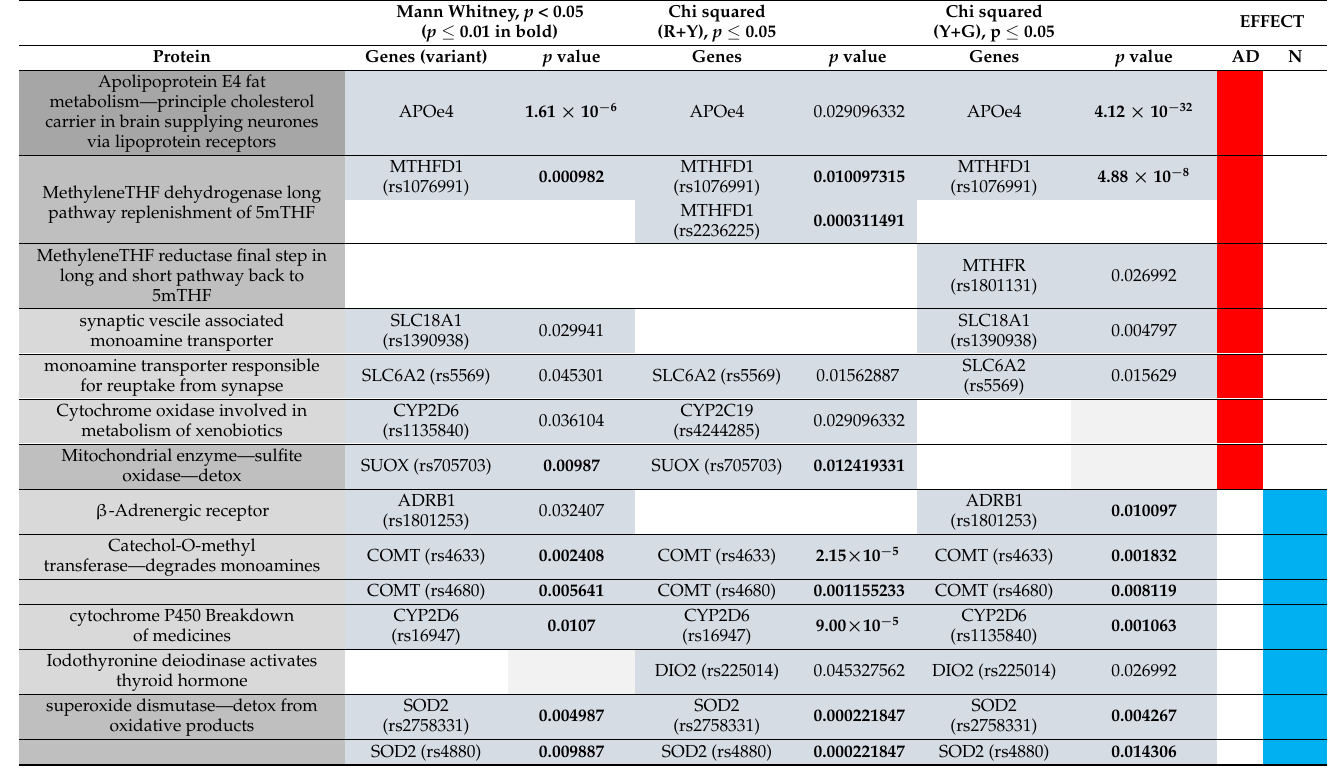
Table 5. Gene variants are significantly associated with normal ageing and Alzheimer’s